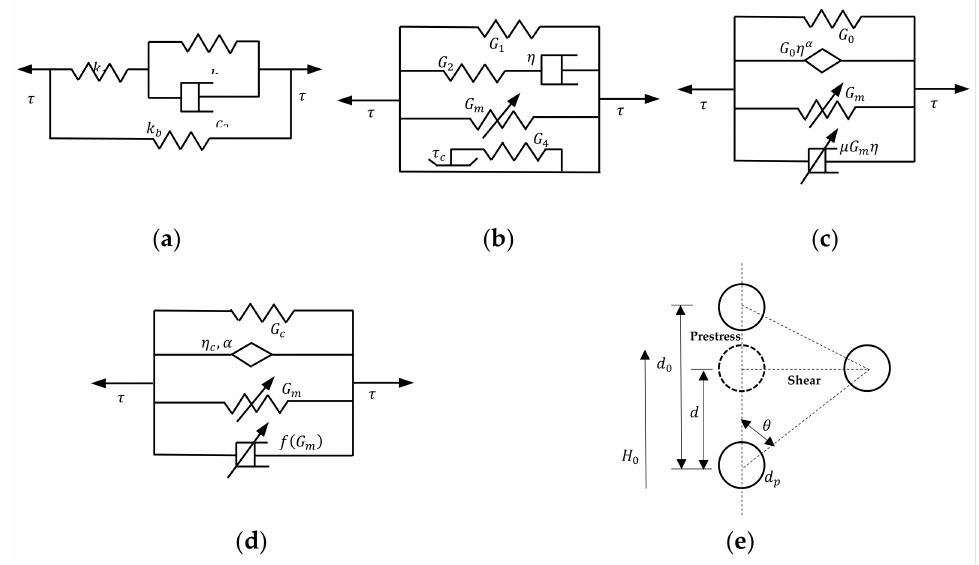
Figure 1. Parametric Model. ( a ) M1 ( b ) M2 ( c ) M3 ( d ) M4 ( e )